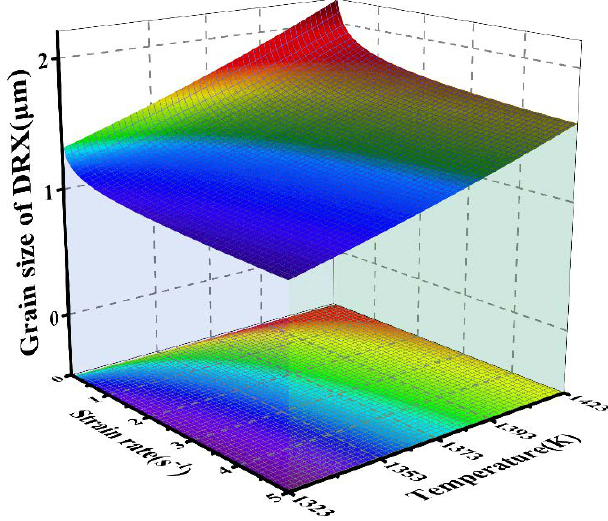
Figure 14. 3D map of the computed mathematical model of AGS of DRX.